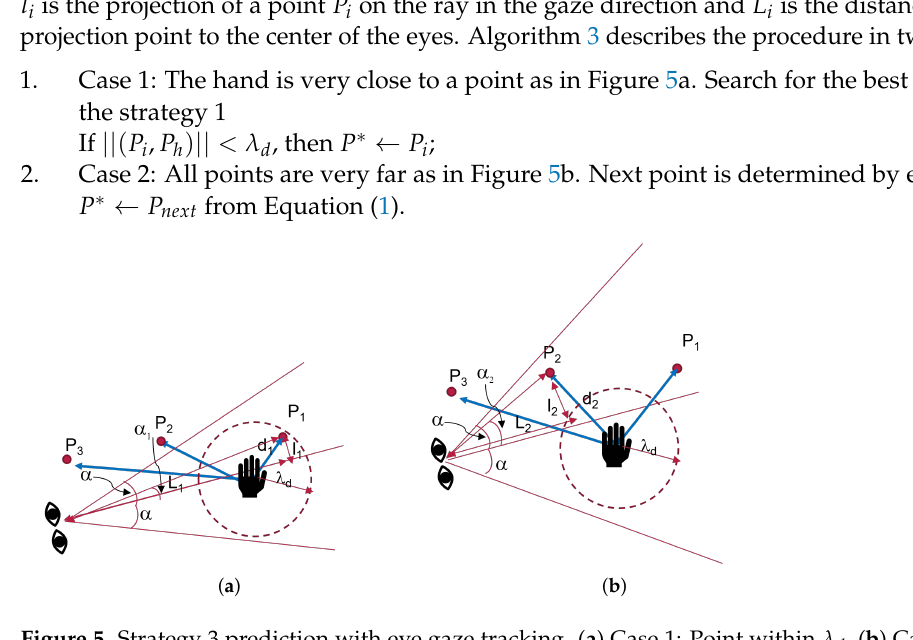
Figure 5. Strategy 3 prediction with eye gaze tracking. ( a ) Case 1: Point within λ d , ( b ) Case 2: All points outside λ d